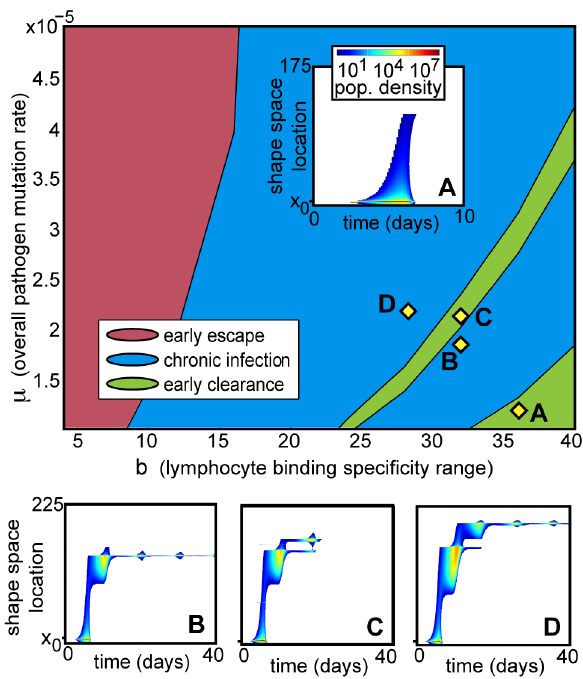
Figure 4. Phase diagram of deterministic infection trajectories under low homeostatic pressure, as a function of mutation rate m and T-cell specificity range b . In most cases, infections with a higher mutation rate in systems with narrower immune specificity range (i.e. higher m and lower b ) are more successful at avoiding early clearance, but a band of cleared infections in the otherwise chronic regime highlights a trade-off: pathogen must mutate fast enough to evade an existing immune response, while keeping mutant numbers low enough to avoid stimulating another. A. Shape space distribution of pathogen infection with a low mutation rate: the original inoculation and all mutants are killed by the initial immune response. B. A faster mutation rate and narrower immune response allows pathogen mutants to avoid the initial immune response and establish a chronic infection. C. As mutation rate increases and specificity range narrows, an increased number of pathogens avoid the initial immune response; this stimulates a more effective secondary response, which is able to clear the entire mutant population. D. Chronic infection is established at a higher mutation rate when the secondary pathogen peak is able to establish mutants that can evade the secondary immune response. All infections have j ~ 6 : 7 | 10 { 5 day { 1 ; other parameters are given